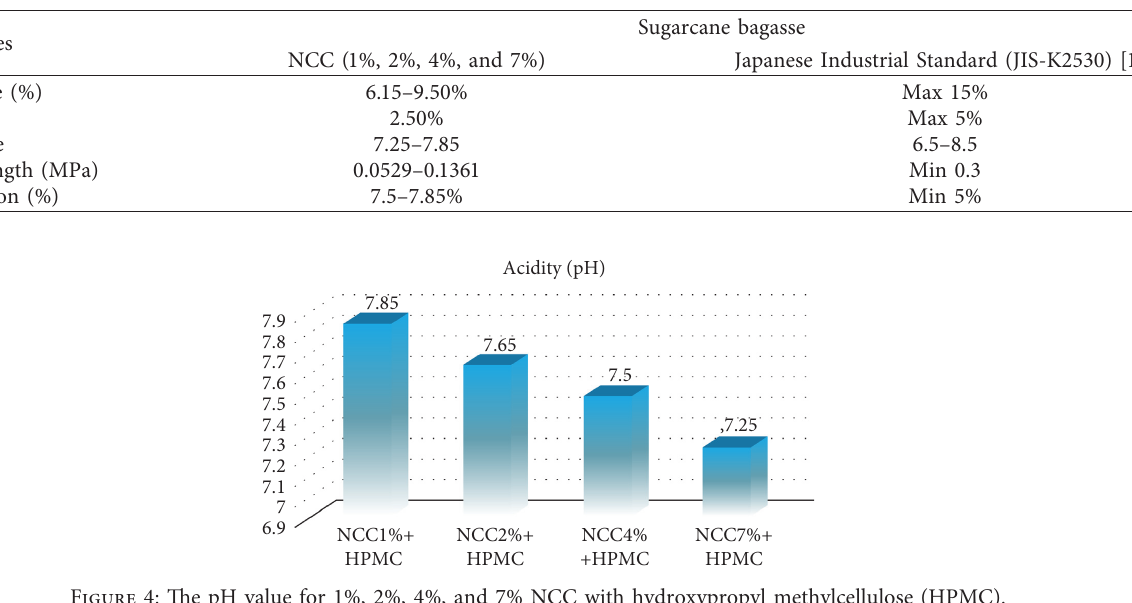
Table 3: Physicochemical properties of nanocrystalline cellulose (NCC).